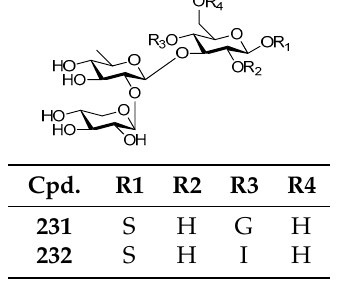
Figure 43. Structure of compound 230.